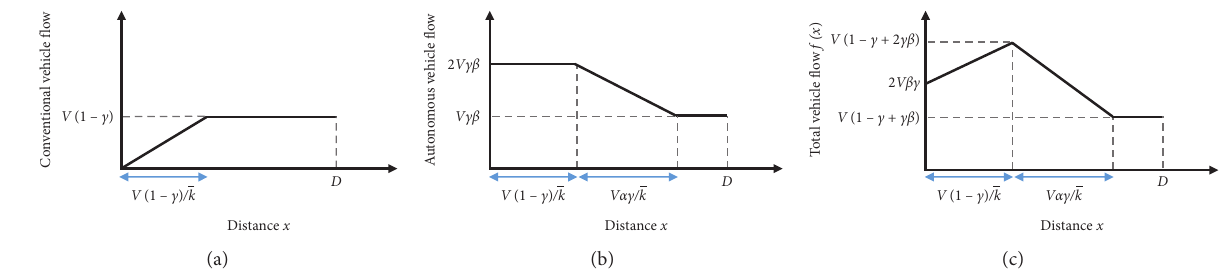
Figure 5: (a) Conventional vehicle flow, (b) autonomous vehicle flow, and (c) total vehicle flow.